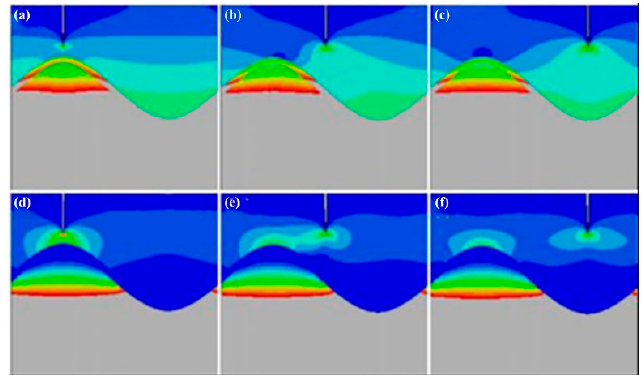
Figure 7. Stress distribution for the TGO with different elastic modulus and surface crack locations: ( a ) peak, E TGO = 400 GPa, ( b ) middle, E TGO = 400 GPa, ( c ) valley, E TGO = 400 GPa, ( d ) peak, E TGO = 40 GPa, ( e ) middle, E TGO = 40 GPa, ( f ) valley, E TGO = 40 GPa. In these cases, the crack length was selected to be 20 mm, other parameters were considered to be same. Reprinted with permission from [59]; Copyright 2012 Elsevier.